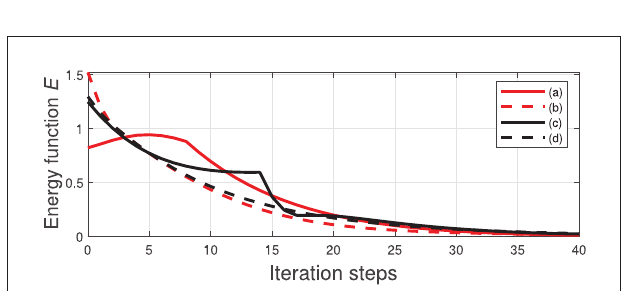
FIGURE 10 | Minimization process of the energy function E